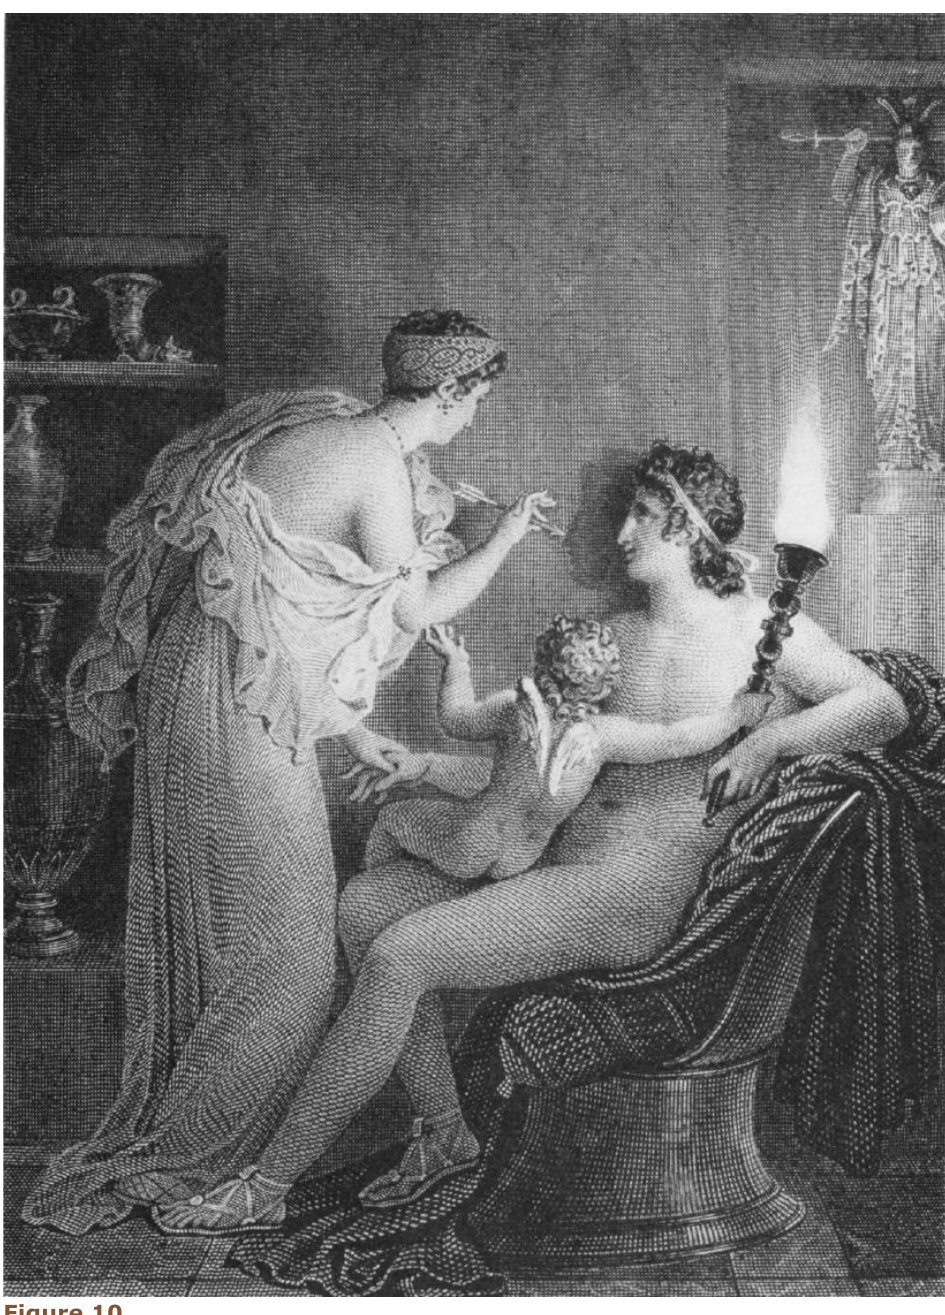
Louis-Pierre Henriquel-Dupont after Anne-Louis Girodet, The Origin of Painting , from Oeuvres Posthumes de Girodet-Trioson, Peintre d’Histoire , ed. P.A. Coupin (Paris: Jules Renouard, 1829), unpag. (photo: